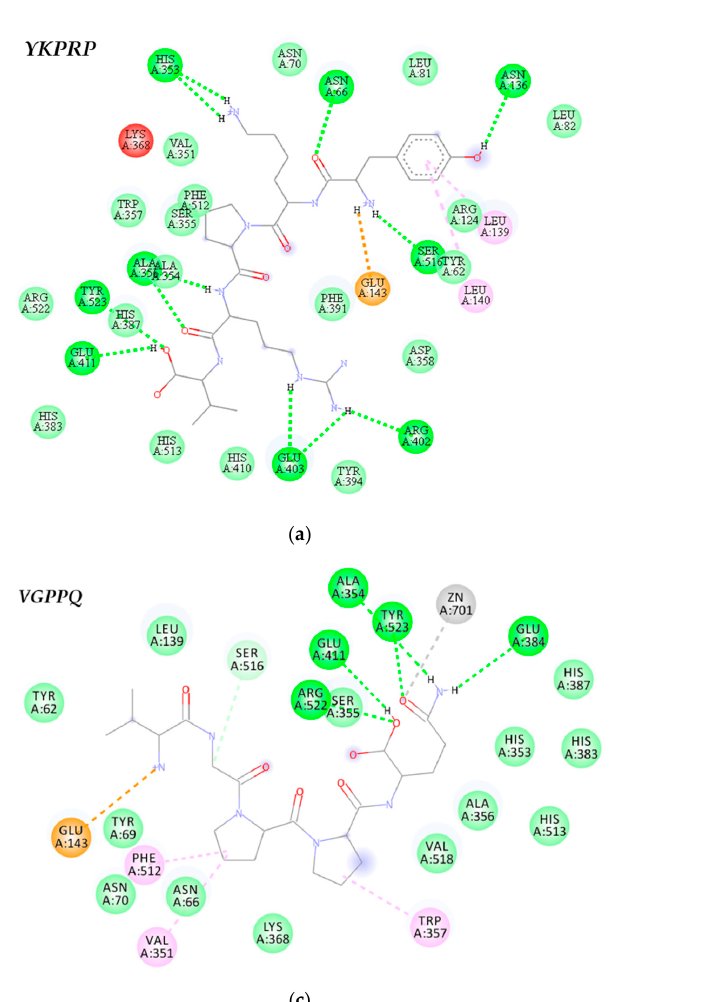
Figure 4. 2D model of the predicted binding mode of ( a ) YKPRP, ( b ) PHGAP, ( c ) VGPPQ, and ( d ) captopril to the angiotensin-converting enzyme (ACE). Images were obtained with Discovery Studios Visualizer Software and the best scored docking pose is